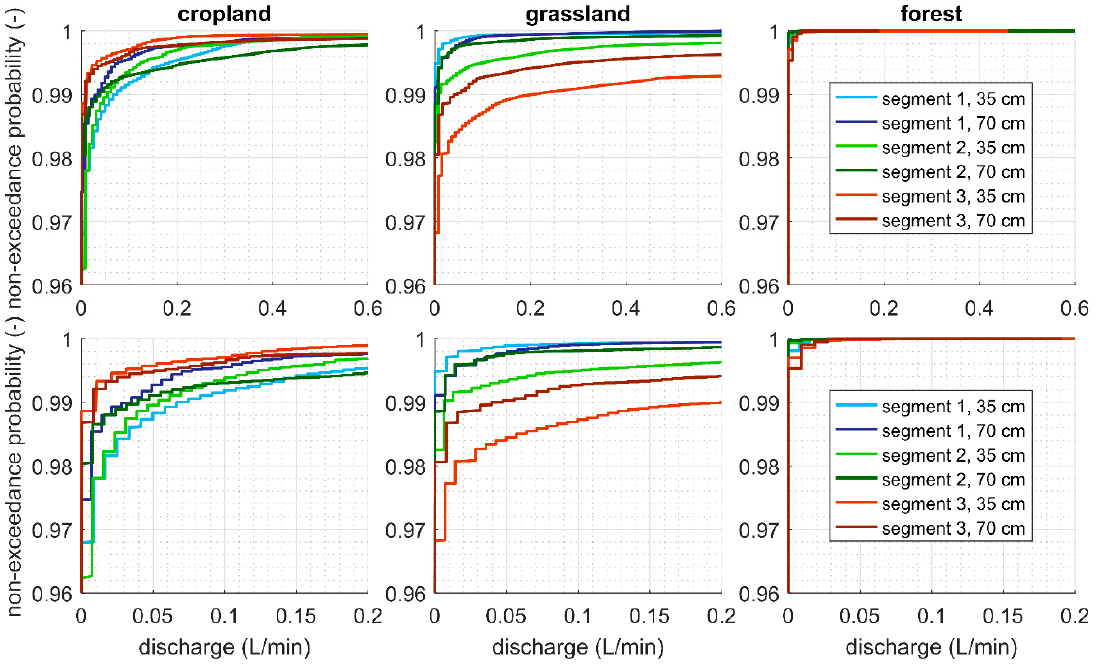
Figure 7. Cumulative distribution functions of subsurface flow at different segments of the three land use types; upper and lower figures differ in the scaling of the x-axis.